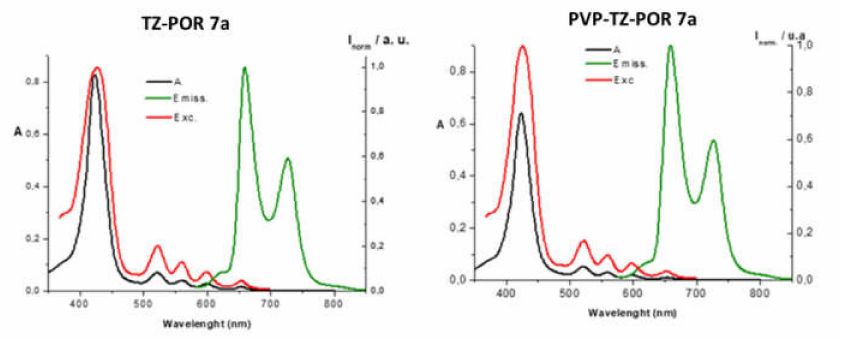
Figure 1. Absorption (A) and normalized emission (Emiss.) and excitation (Exc.) spectra of TZ-POR 7a vs PVP-TZ-POR 7a in DMF / H 2 O (9:1) ([TZ-POR 7a ] = [PVP-TZ-POR 7a ] = 0.5x10 –6 M, λ exc POR 7a = 561 nm and λ emis POR 7a = 728 nm; λ exc PVP-TZ-POR 7a = 560 nm and λ emiss PVP-TZ-POR 7a = 726